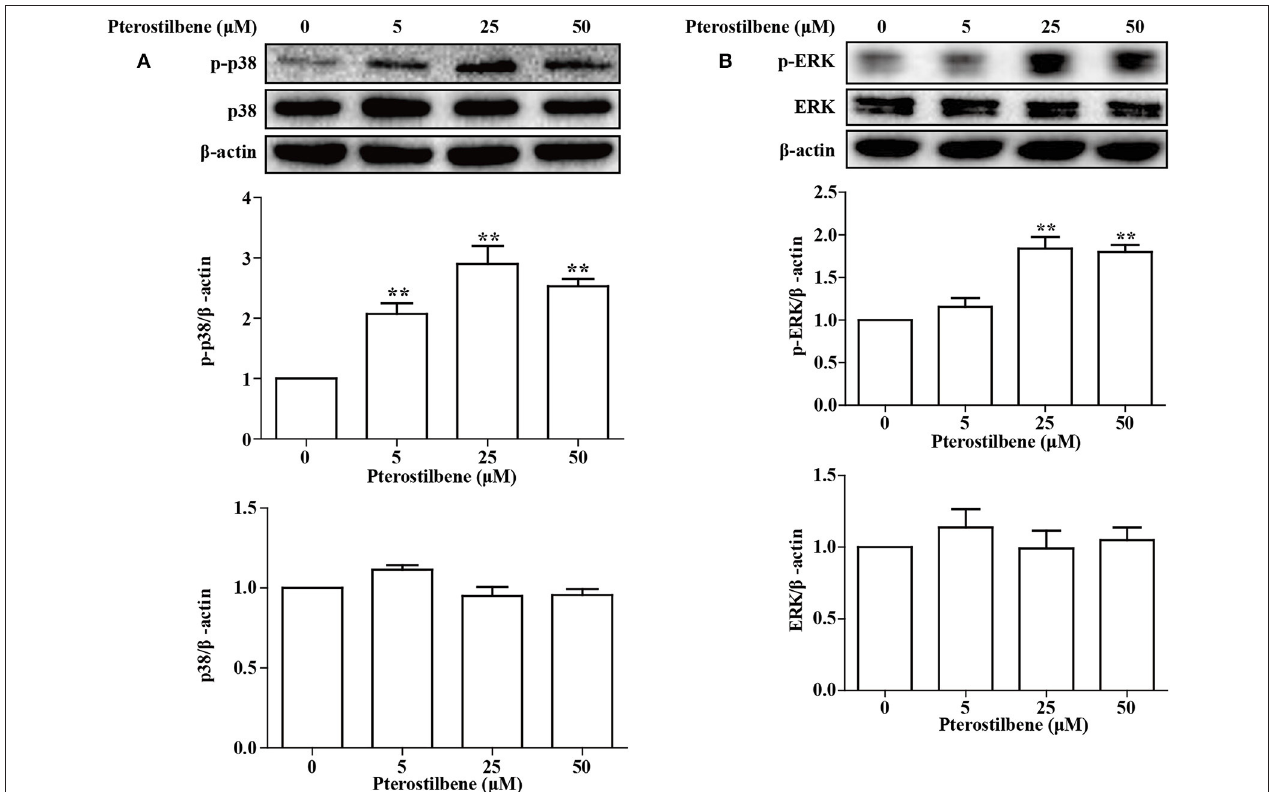
FIGURE 10 | Influence of pterostilbene on p38 and ERK1/2 MAPK pathways. Cells were untreated or treated with pterostilbene (0, 5, 25, and 50 µ M) for 24h and analyzed by Western blotting. Reported values are mean ± SEM. ** p < 0.01 indicate significant differences compared with the control group.